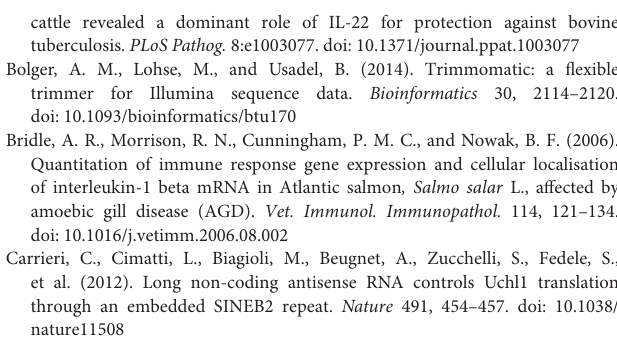
Supplementary Figure 3 | Bar graphs showing the top functional categories in the gene ontology domain of biological processes. The pathways are indicated on the y-axis, while the x-axis depicts the significant scores (– log 10 p value calculated based on Fisher exact test). (a) Naïve vs. primary infection of down-regulated genes; (b) Naïve vs. secondary infection of down-regulated genes; (c) Naïve vs. secondary infection of up-regulated genes; (d) Naïve vs. secondary infection of up-regulated immune genes. Supplementary Figure 4 | Distribution of AGD scores of the 2016 year-class of the SalmoBreed population. AGD scores were based on the sum of Taylor et al. (2009a,b) score of all 16 gill surfaces of infected animals. Supplementary Figure 5 | Quantile-quantile plot for the test statistics used in the genome-wide association analysis of resistance to AGD. Supplementary Figure 6 | Expression bar plot of interleukin-1 beta, shown in FPKM, and the associated standard errors for the 36 sequenced animals at the naïve stage (n), first infection (i1), second infection with score 2 (i2_2) or the second infection with score 3 (i2_3). Supplementary Figure 7 | (a) Accuracy of selection of genomic predictions and (b) regression coefficient of adjusted phenotype on genomic breeding values for different λ (blending of two genomic relationship matrices) values. The two genomic relationship matrices were generated for SNPs that were either within significant genes in gene expression analysis or not. Markers within significant DE genes were also weighted with the – log 10 p of that